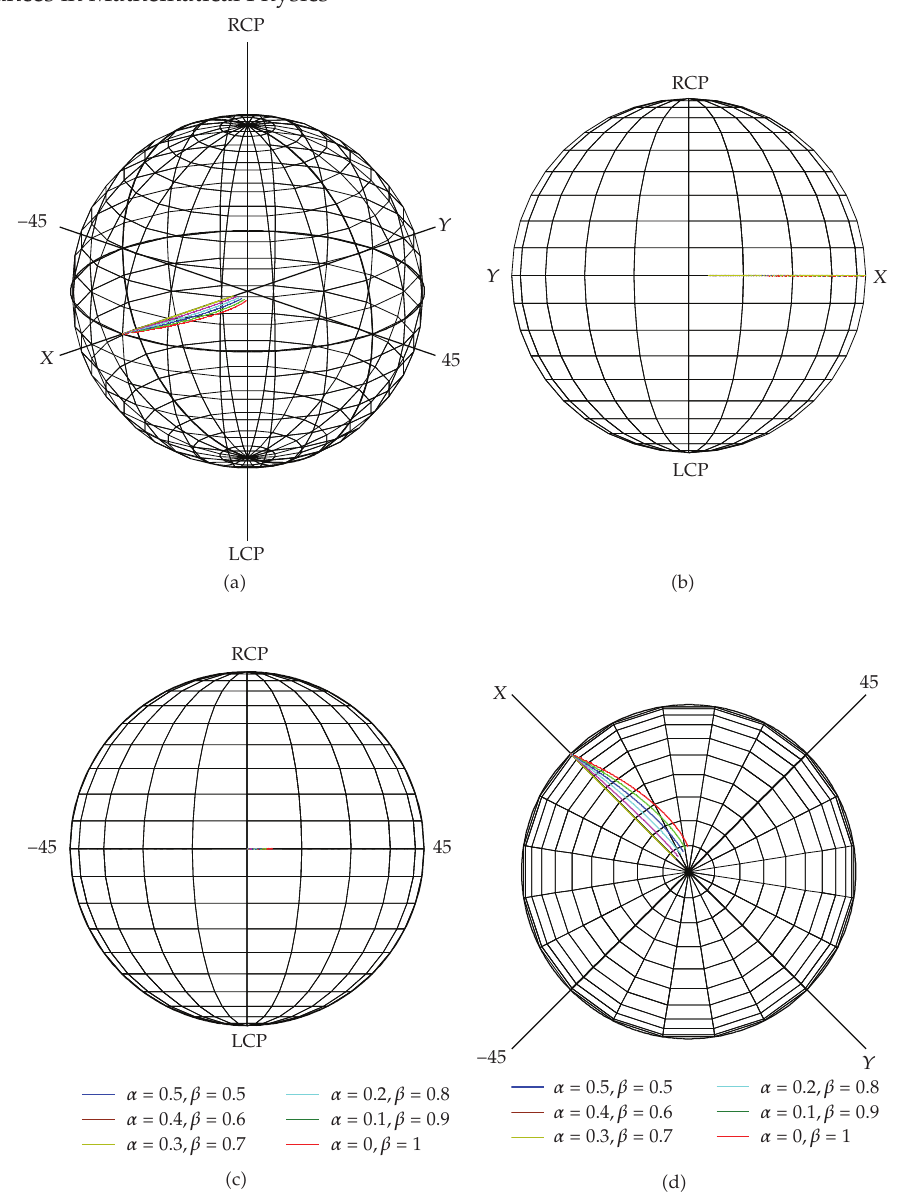
Figure 18: Photon polarization dynamics on the poincare sphere for large Δ